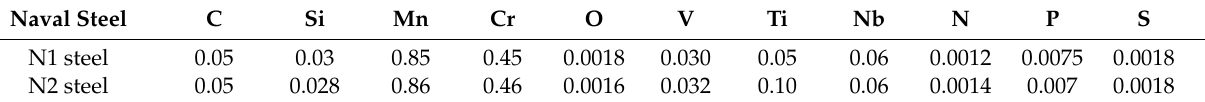
Table 1. Chemical compositions of the tested high strength naval steel (Wt %).